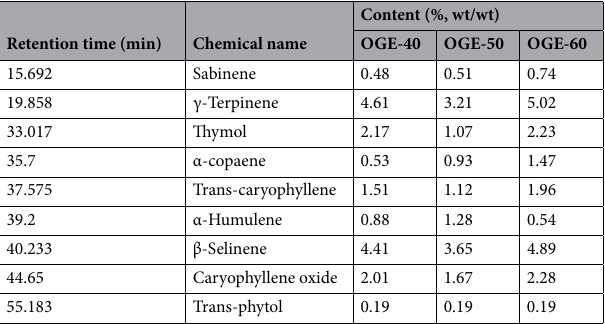
Table 1. Chemical composition of O. gratissimum ethanolic extract.